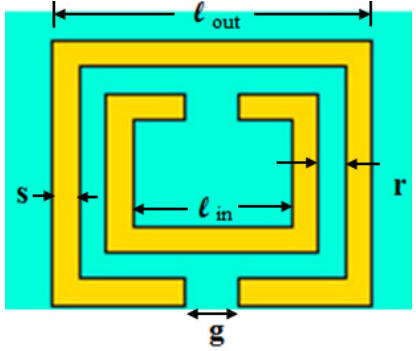
Figure 6. Square-ring CSRR unit cell.